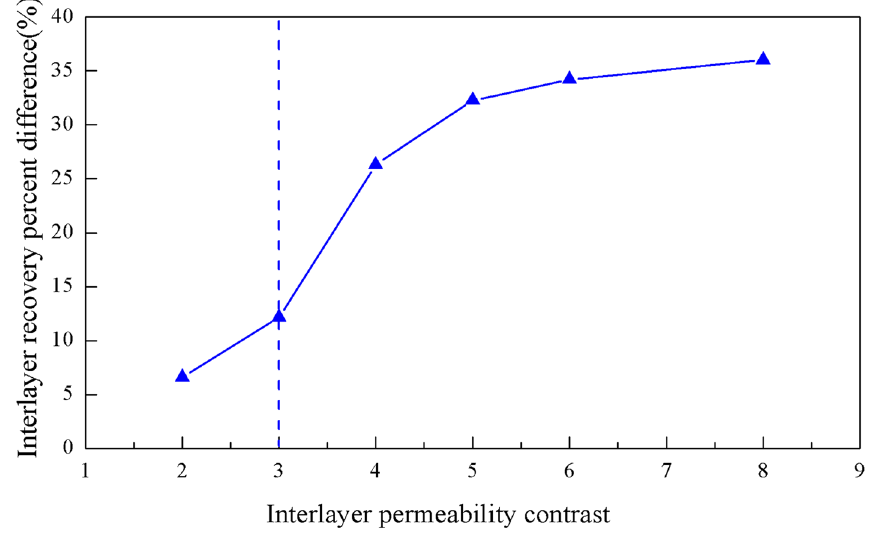
Fig. 3 Relation between inter- layer recovery percent differ- ence and oil viscosity